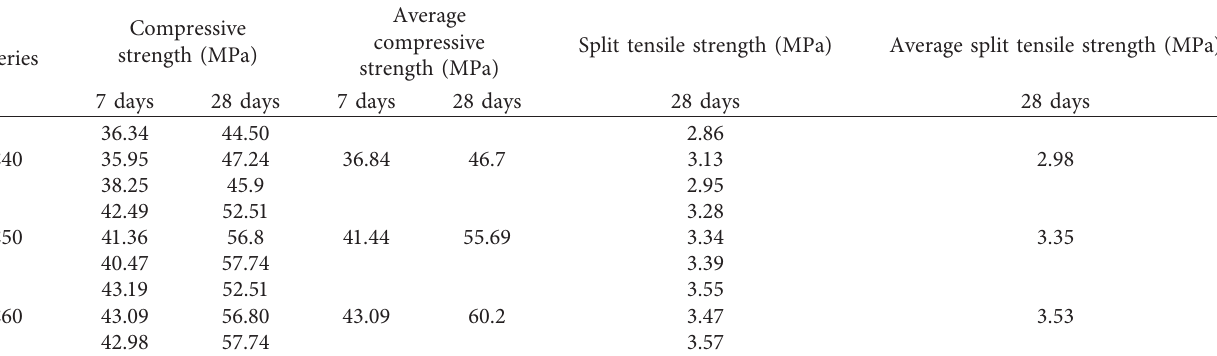
Table 4: The compressive and split tensile strength of